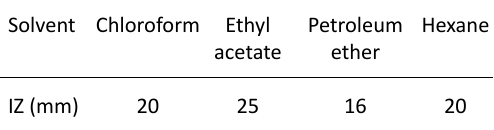
Table 6. Effect of different solvent extracts on